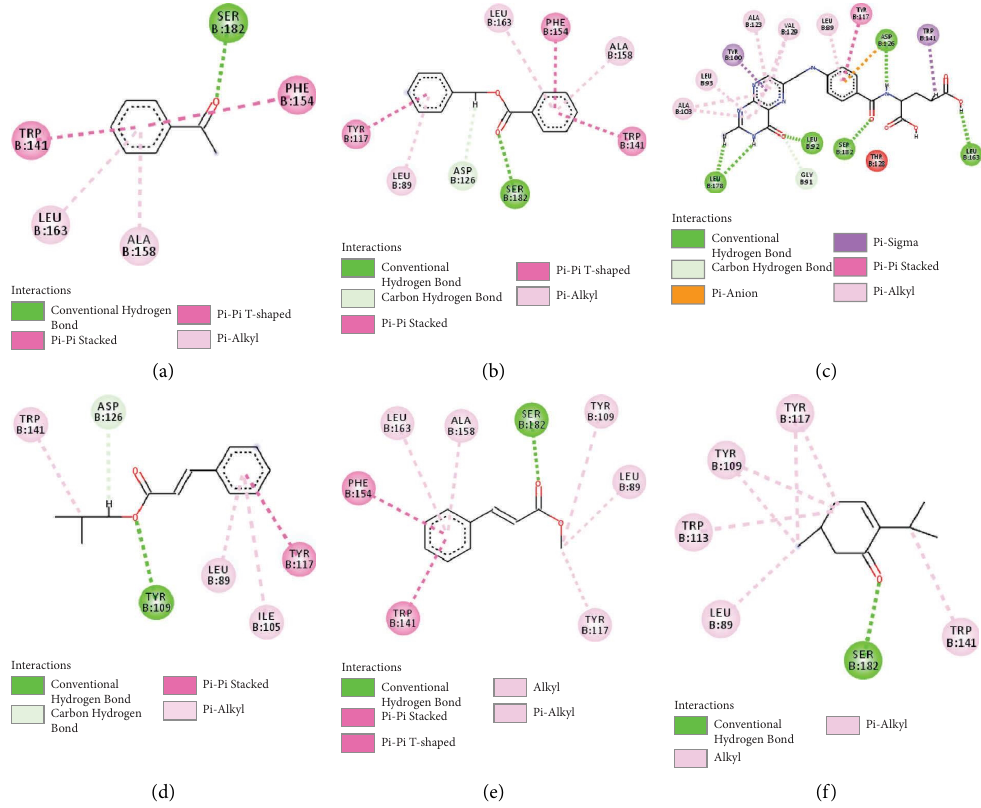
Figure 4: Molecular docking results: 2D view of interactions between top compounds and the LasR protein. (a) Acetophenone, (b) benzyl benzoate, (c) folic acid (d) isobutyl cinnamate, (e) methyl cinnamate, and (f)